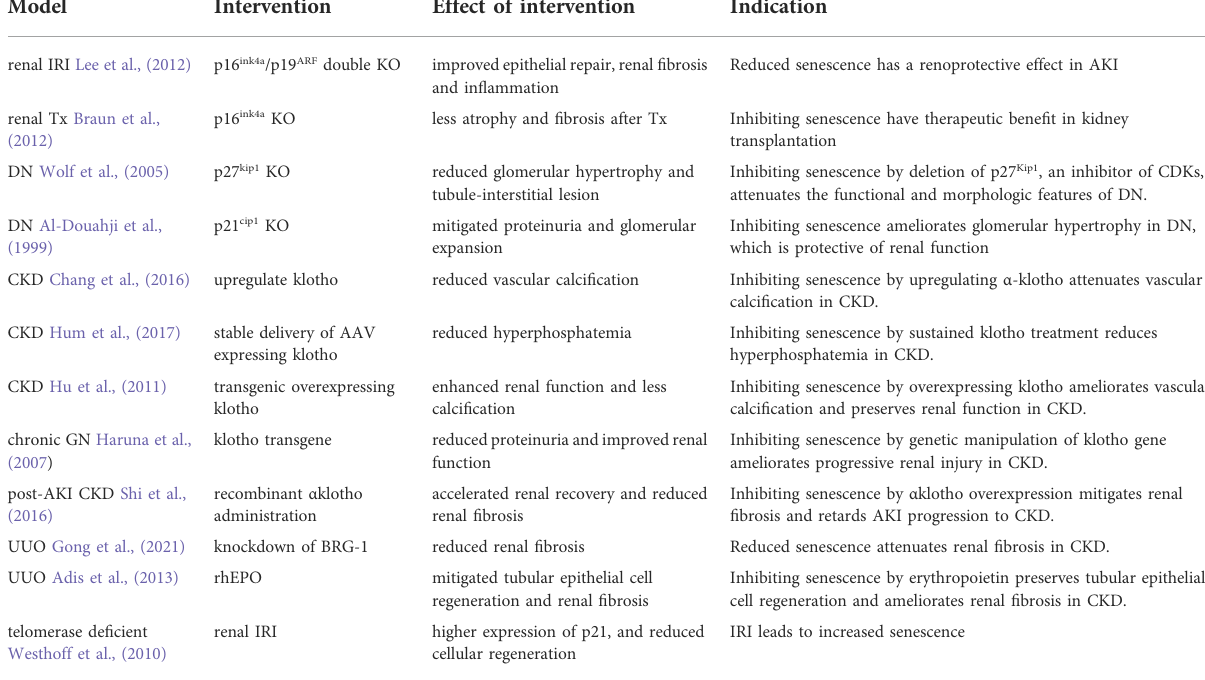
TABLE 1 Animal model studies on the relationship between cellular senecence and chronic kidney disease